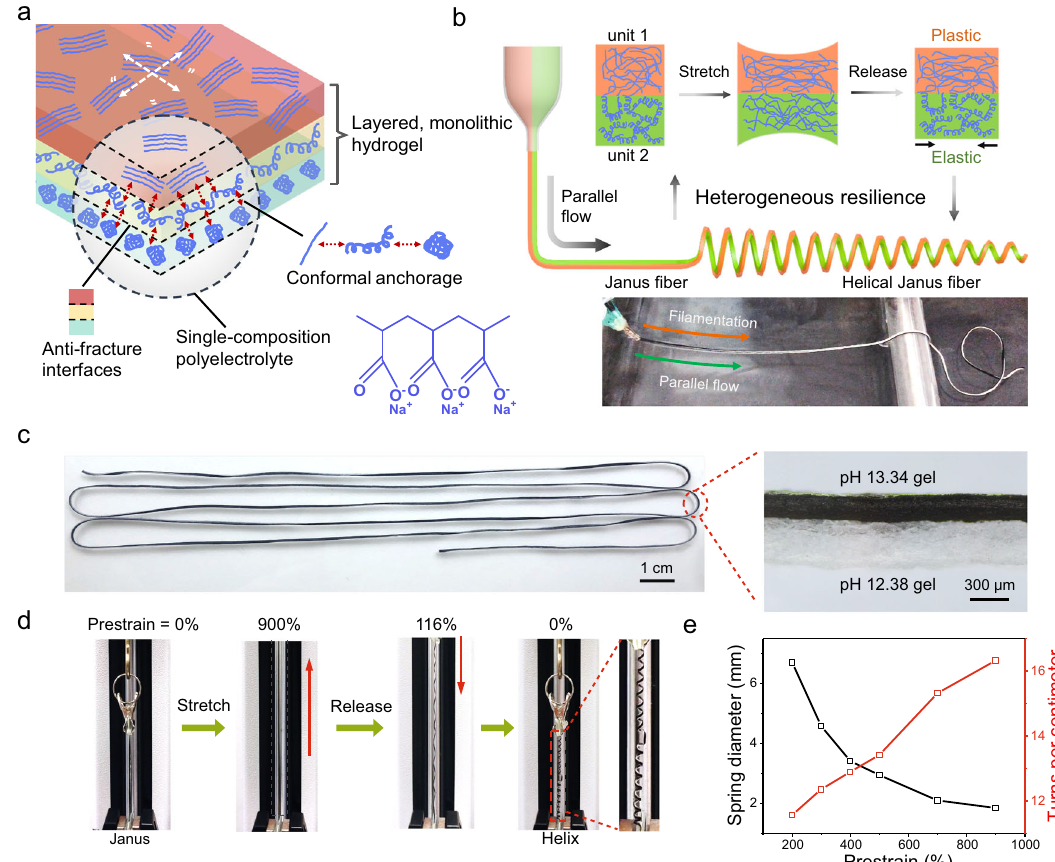
Fig. 3 Processability of the macromolecule conformation tunable hydrogels for monolithic, polymorphic hydrogel fi ber devices. a Schematic illustration of layered, monolithic hydrogels of varied macromolecule conformations. b Schematic illustration for the preparation of helical Janus hydrogel fi ber (top), and fabrication of continuous Janus hydrogel fi ber via a parallel-axial dual-spinneret (bottom). c Photograph of the Janus hydrogel fi ber of >1 meter in length and optical microscope image showing the conformal interface of layered hydrogel micro fi bers. d Formation of a helical Janus fi ber in response to 900% prestrain. e Spring diameter and number of coils of helical Janus fi bers versus applied